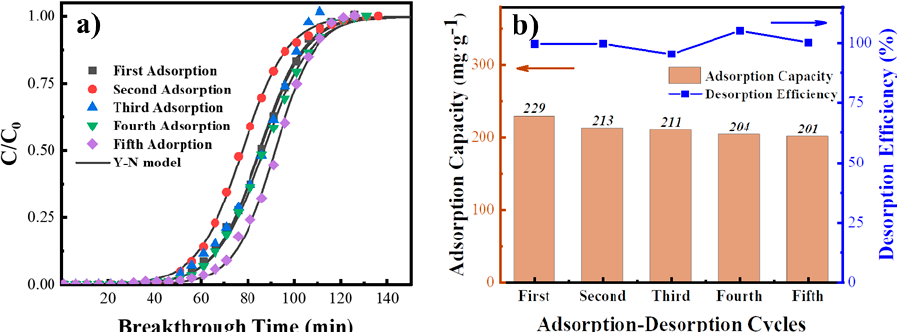
Figure 11. ( a ) Breakthrough curves during the cycle experiment. ( b ) Adsorbing capacity and desorption efficiency.